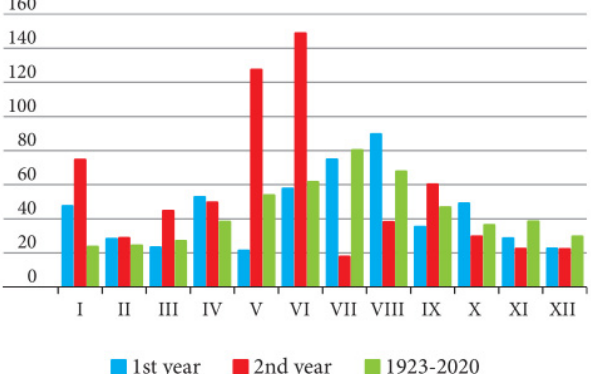
Figure 2. Cumulative precipitation in 1st and 2nd year of the study and the multi-annual period (1923 − 2020).